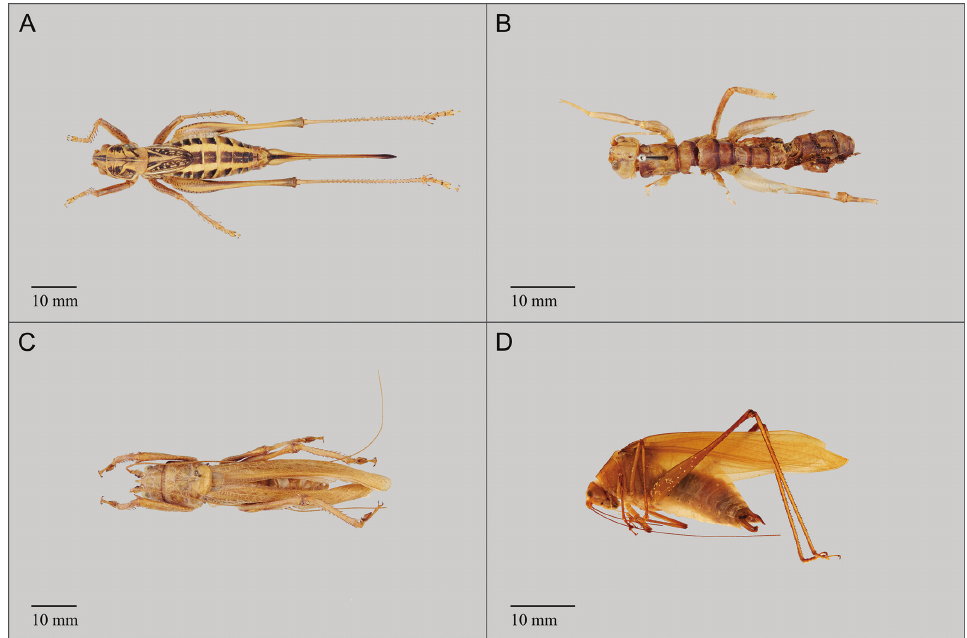
Figure 1. This figure shows A: dorsal view the paratype of Gampsocleis acutipennis Karabag, 1955; B: dorsal view of the holotype of Lezina acuminata Ander, 1938, which was declared as missing by Weidner (1966, 1977) and was recently sent back by NHM Lund; C: dorsal view of a paratype of Salomona sigma Redtenbacher, 1891; D: lateral view of the potential type specimen of Para- caedicia appendiculata Fritze, 1914; the status of the specimen is unclear; the label is shown in Figure